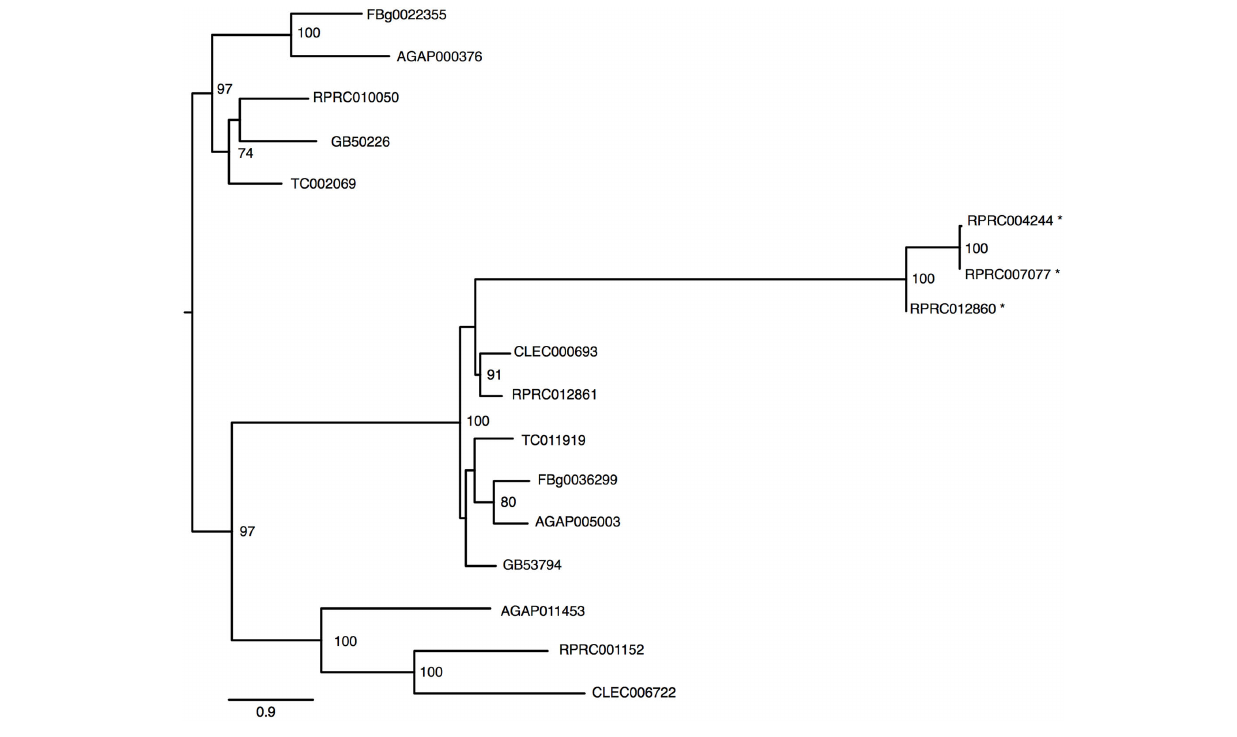
FIGURE 4 | Phylogenetic analysis of Transferrin superfamily genes orthologs. Maximum-likelihood tree of transferrins orthologs. Numbers on the branches are bootstrap support values from 500 replicates. Only numbers 50% or higher are shown. “ ∗ ” indicate R. prolixus putative melanotransferrins pseudogenes. The sequence codes used were R. prolixus (RPRC), D. melanogaster (FBg), T. castaneum (TC), C. lectularius (CLEC), A. mellifera (GB) and A. gambiae